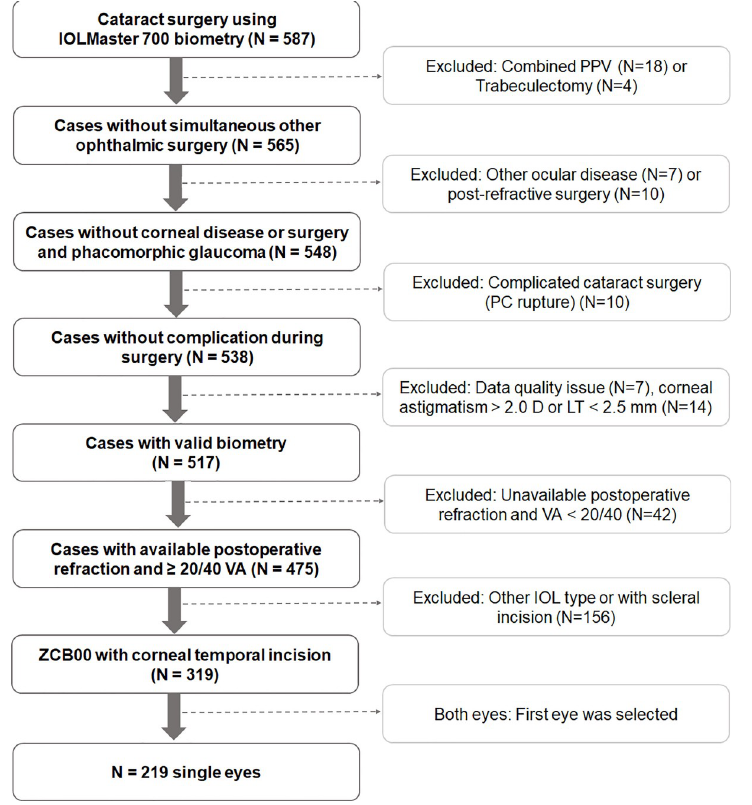
Fig 1. Overview of the study selection